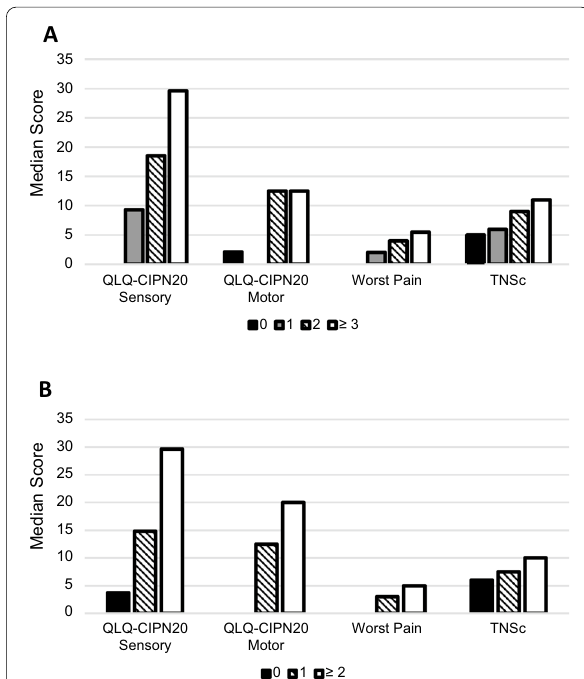
Fig. 1 Median CIPN patient-reported and composite measure scores by PRO-CTCAE item response category at T3. a PRO-CTCAE numbness and tingling severity item. a Differences in median QLQ-CIPN20 Sensory, QLQ-CIPN20 Motor, 0–10 worst CIPN pain intensity NRS ( n 138), and TNSc© scores ( n 118) by PRO-CTCAE = = Numbness and Tingling Severity Item Score at T3. Severity 0; TNSc© = n 33; QLQ-CIPN20 and worst pain measures n 40. Severity 1; = = = TNSc© n 49; QLQ-CIPN20 and worst pain measures n 54. = = Severity 2; TNSc© n 33; QLQ-CIPN20 and worst pain measures = = n 38. Severity 3; TNSc© n 3; QLQ-CIPN20 and worst pain = ≥ = measures n 6. b PRO-CTCAE Numbness and Tingling Interference = Item. b Differences in median QLQ-CIPN20 Sensory, QLQ-CIPN20 Motor, 0–10 worst CIPN pain intensity NRS ( n 138), and TNSc© = scores (